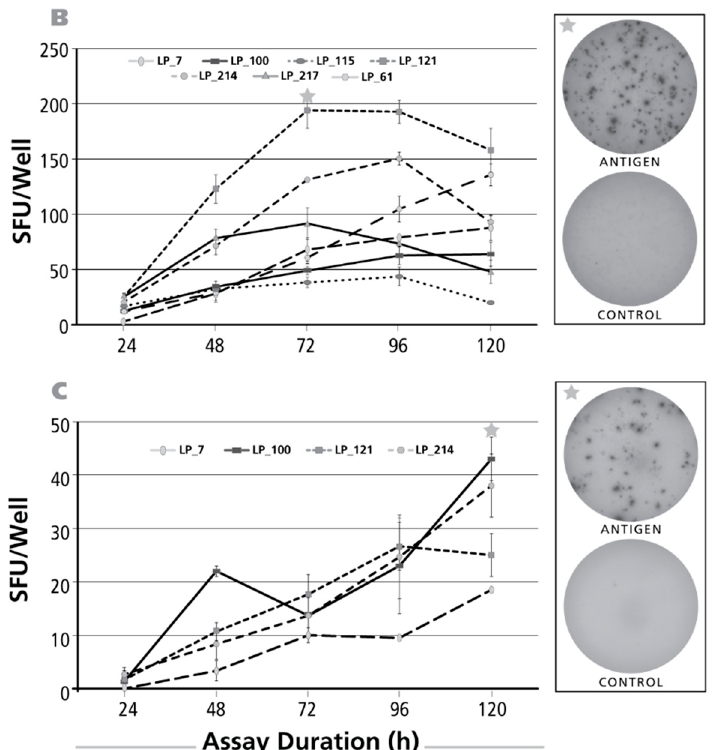
Figure 2. Kinetics of the antigen-induced IL-17 recall response. Donors and antigens were selected that scored IL-17 positive in the screening experiments (Figure 1). Panel ( A ) shows the test results for CMV gr.2 antigen-induced IL-17 production; in Panel ( B ) Purified Protein Derivative of PPD-triggered IL-17 was tested; in Panel ( C ) Dust mite was used as the recall antigen to activate IL-17-producing T cells. The donors tested are specified by symbols within each panel. The PBMC (400,000 cells per well) were cultured with the antigen for the time periods specified on the X axis (“Assay Duration”), and after the IL-17 spots were counted as SFU/well, Y axis. Each data point represents the mean and SD for the SFU counts in the three replicate wells tested. Of note, the time course was established testing the same cells in a single experiment: thus, for the different assay durations shown, only the length of the antigen stimulation period varied. On the right of each panel, on the top, the image of the respective antigen containing well is shown, with an asterisk marking the corresponding data point in the graph. The well image on the bottom shows the matching medium control well.